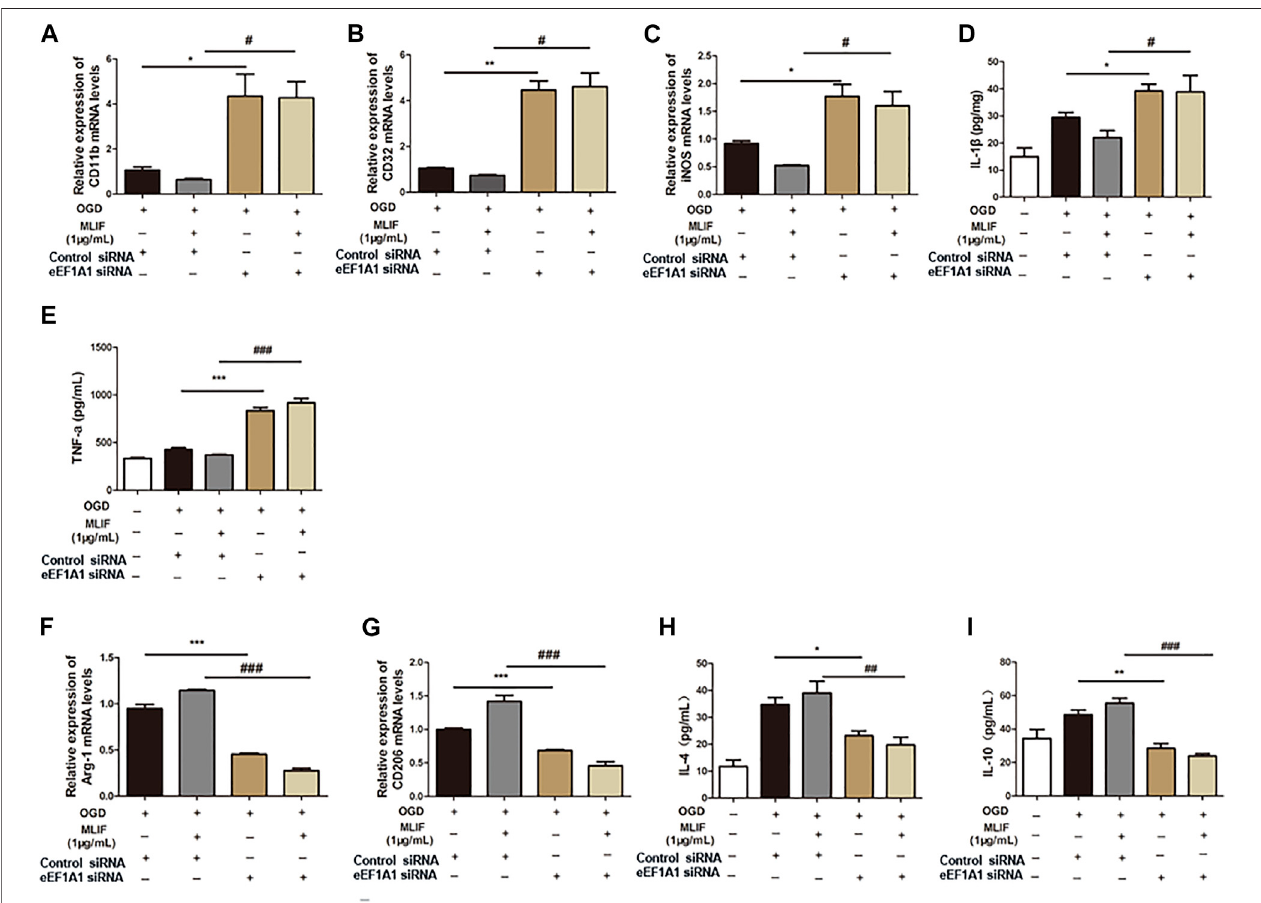
FIGURE 5 | Regulation effect provided by MLIF was inhibited by eEF1A1 siRNA in BV2 microglia. OGD-insulted BV2 microglia transfected with eEF1A1 siRNA or control siRNA were treated with MLIF (1.0 μ g/ml). Real-time PCR was used to detect M1 signature genes CD11b (A) , CD32 (B) , and iNOS (C) and M2 signature genes Arg-1 (F) andCD206 (G) .ELISAwasusedtodetectM1-relatedin fl ammationcytokinesIL-1 β (D) andTNF- α (E) andM2-relatedcytokinesIL-4 (H) andIL-10 (I) inthecell supernatant.Dataareexpressedasthemean ± SEM. N (cid:1) 3.* p < 0.05,** p < 0.01,*** p < 0.001,vsOGD+ControlsiRNAgroup; # p < 0.05, ### p < 0.001,vsMLIF+ Control siRNA